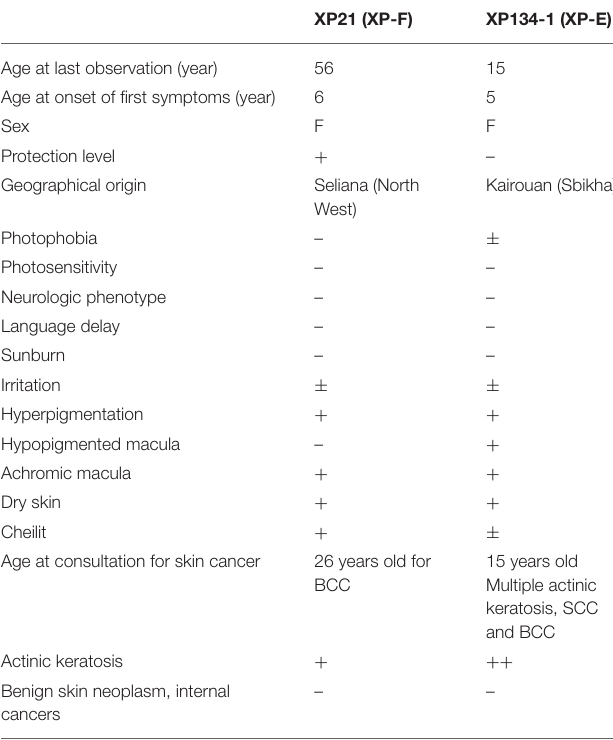
TABLE 1 | Summary of the clinical examination of XP